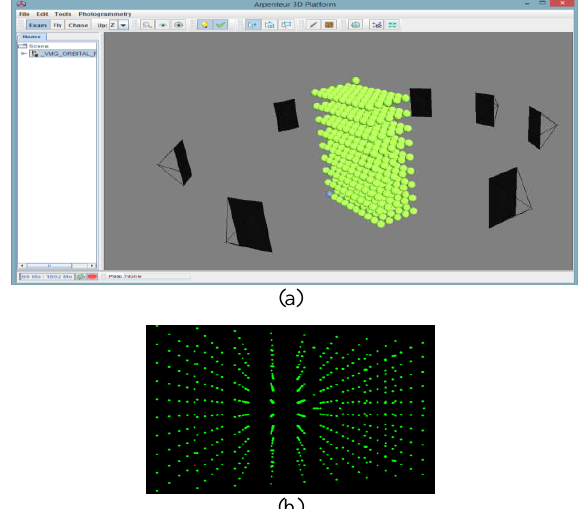
Figure 3. (a) Theoretical model with 19 images and set of 3D points generated with Arpenteur framework (a screenshot from Arpenteur viewer ). (b) a generated image with the projection of 3D points by Arpenteur